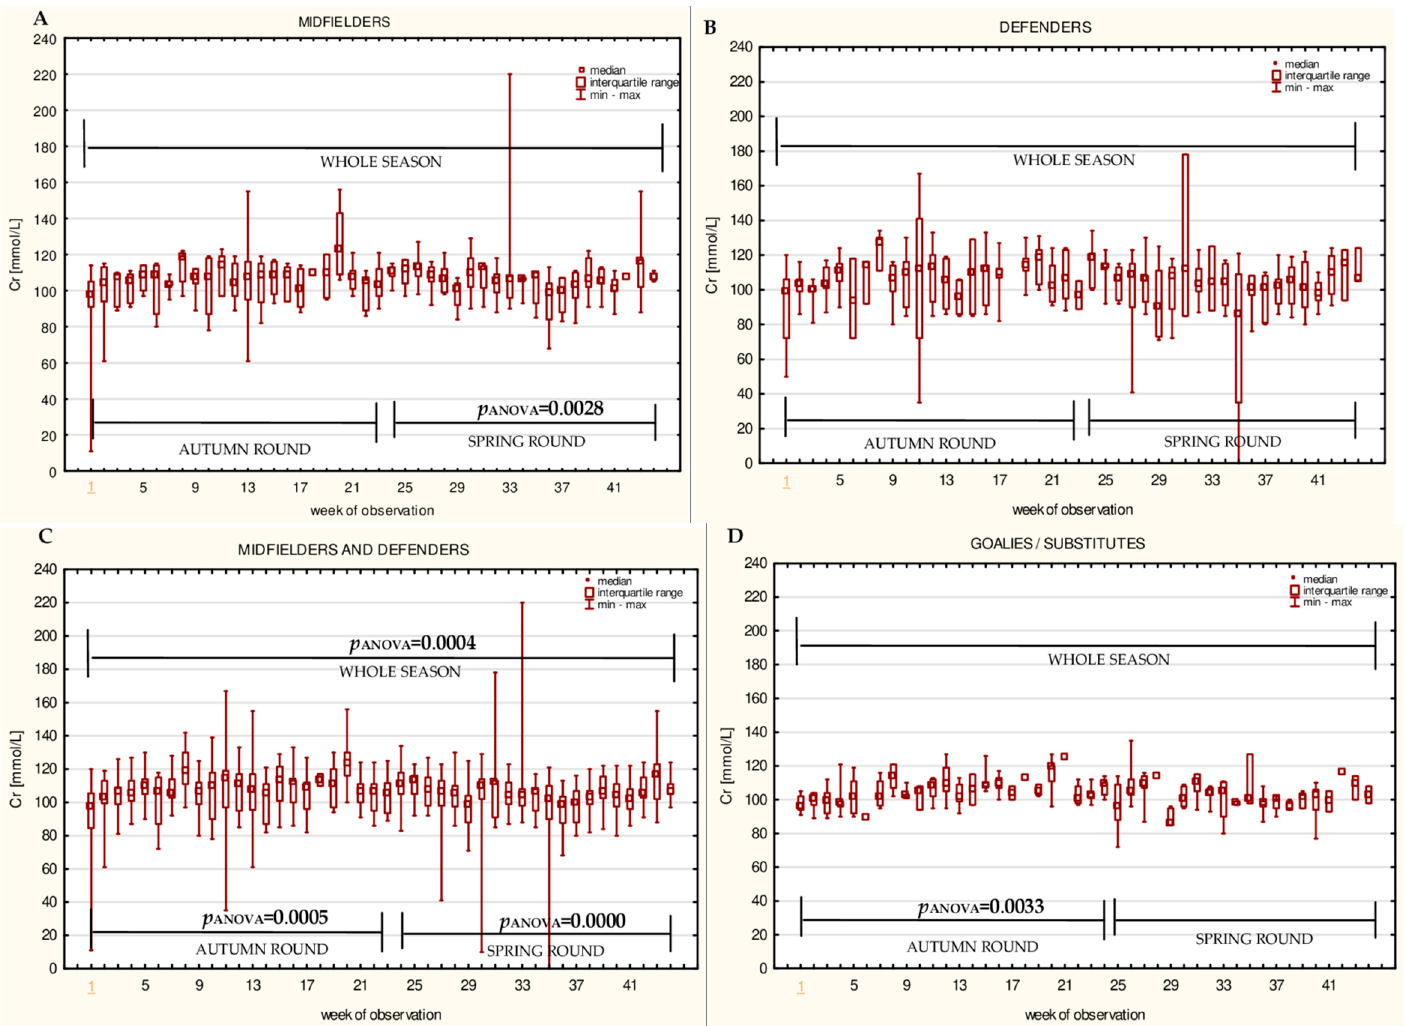
Figure 6. Median creatinine (Cr) levels in: ( A ) The midfielder, ( B ) defender, ( C ) midfielder / defender and ( D ) goalie / substitute subgroups over the course of the soccer match